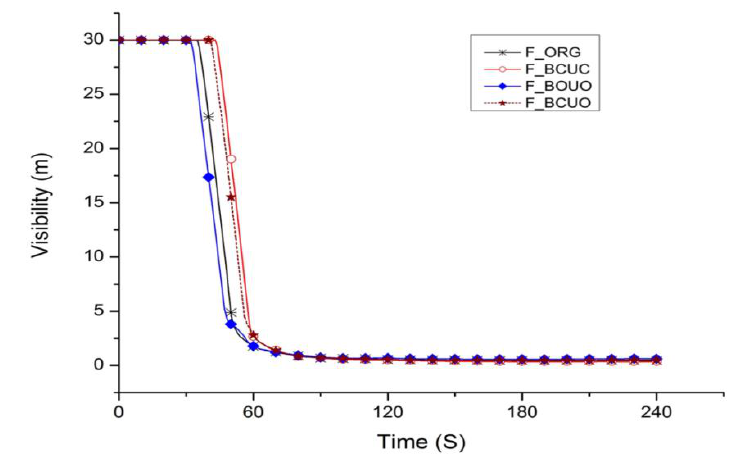
Figure 25. Visibility curves of the roof above Point R.